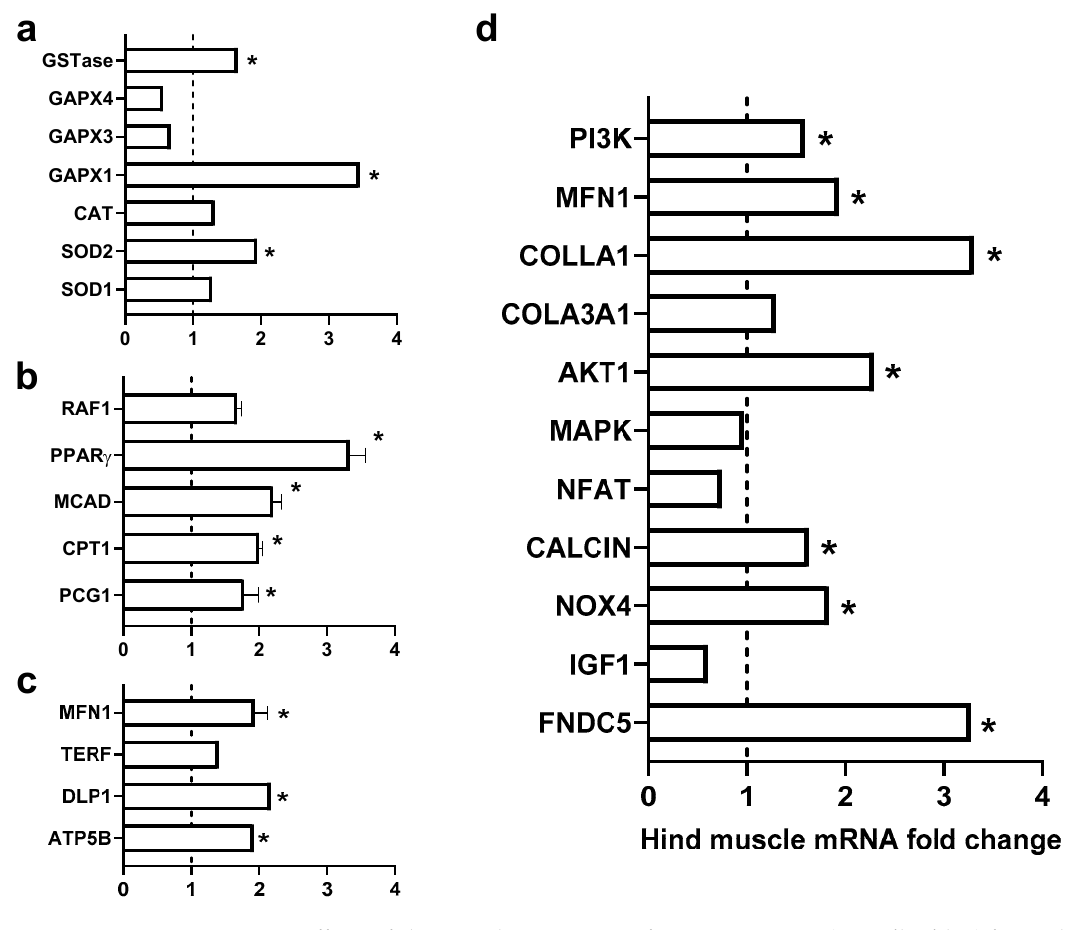
Figure 4. Effects of chronic administration of exogenous irisin (5 mg/kg/day) for 42 days on heart mRNA levels. ( a ) Genes encoding against oxidative stress; ( b ) genes encoding for fatty acid β -oxidation activities; ( c ) mitochondrial fusion; and ( d ) genes encoding for muscle mass and aging. * p < 0.05 in comparison to the control group.